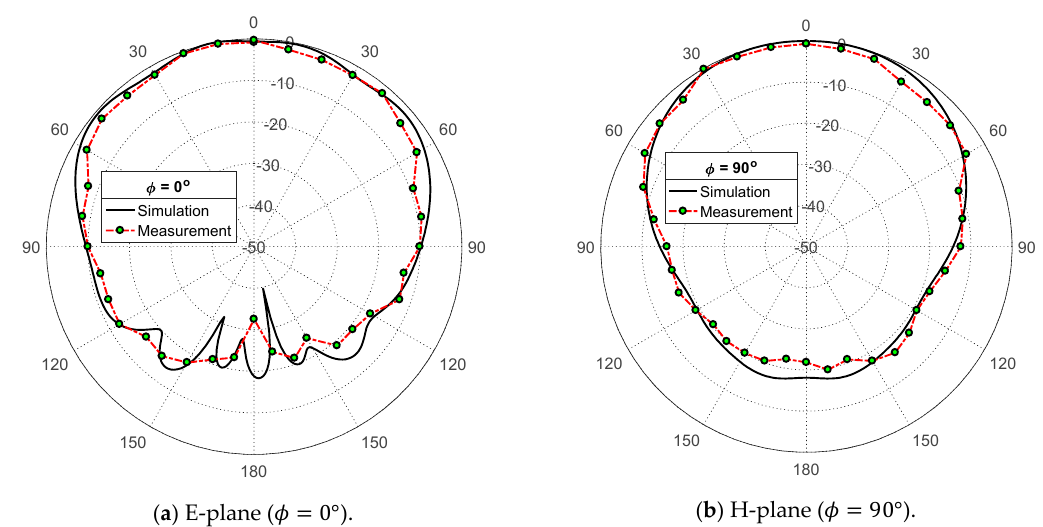
Figure 17. Measured radiation patterns of the proposed dual-band microstrip patch antenna at 38 GHz compared with the simulation results.